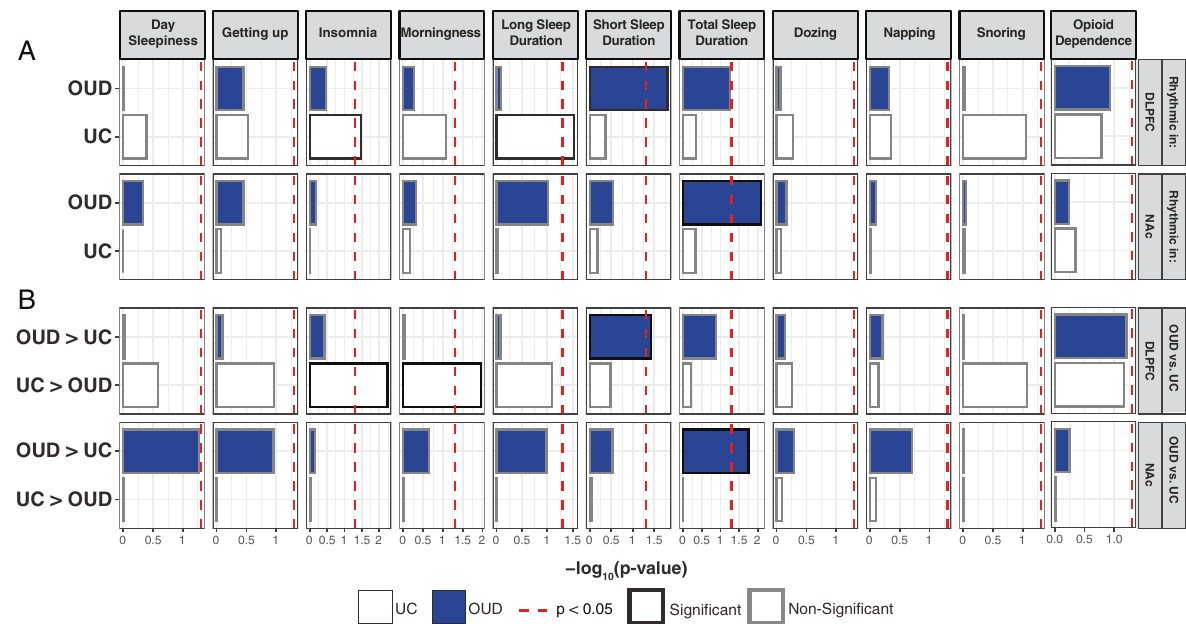
Fig. 5 Rhythmic transcripts in the dorsolateral prefrontal cortex (DLPFC) and nucleus accumbens (NAc) enrich for genetic associations with opioid and sleep-related traits. Genome-wide associated studies (GWAS) have identi fi ed loci associated with various sleep-related traits and opioid dependence. We investigated whether rhythmic transcripts, as well as transcripts that were signi fi cantly more or less rhythmic in subjects with opioid use disorder (OUD), were enriched for genetic associations with sleep-related traits and opioid dependence. A In the DLPFC of unaffected comparison (UC) subjects, there was signi fi cant enrichment of rhythmic transcripts for genes associated with insomnia and long sleep duration. In NAc of OUD subjects, there was enrichment of rhythmic transcripts and transcripts that were more rhythmic in OUD in total sleep duration. There were no signi fi cant associations in the NAc of UC subjects. B Insomnia and morningness were associated with transcripts that were signi fi cantly less rhythmic in DLPFC of OUD subjects. Transcripts in the DLPFC that were more rhythmic in OUD subjects were enriched for genes associated with short sleep duration, while transcripts that were more rhythmic in the NAc of OUD subjects were enriched for total sleep duration. No signi fi cant enrichments were identi fi ed for opioid